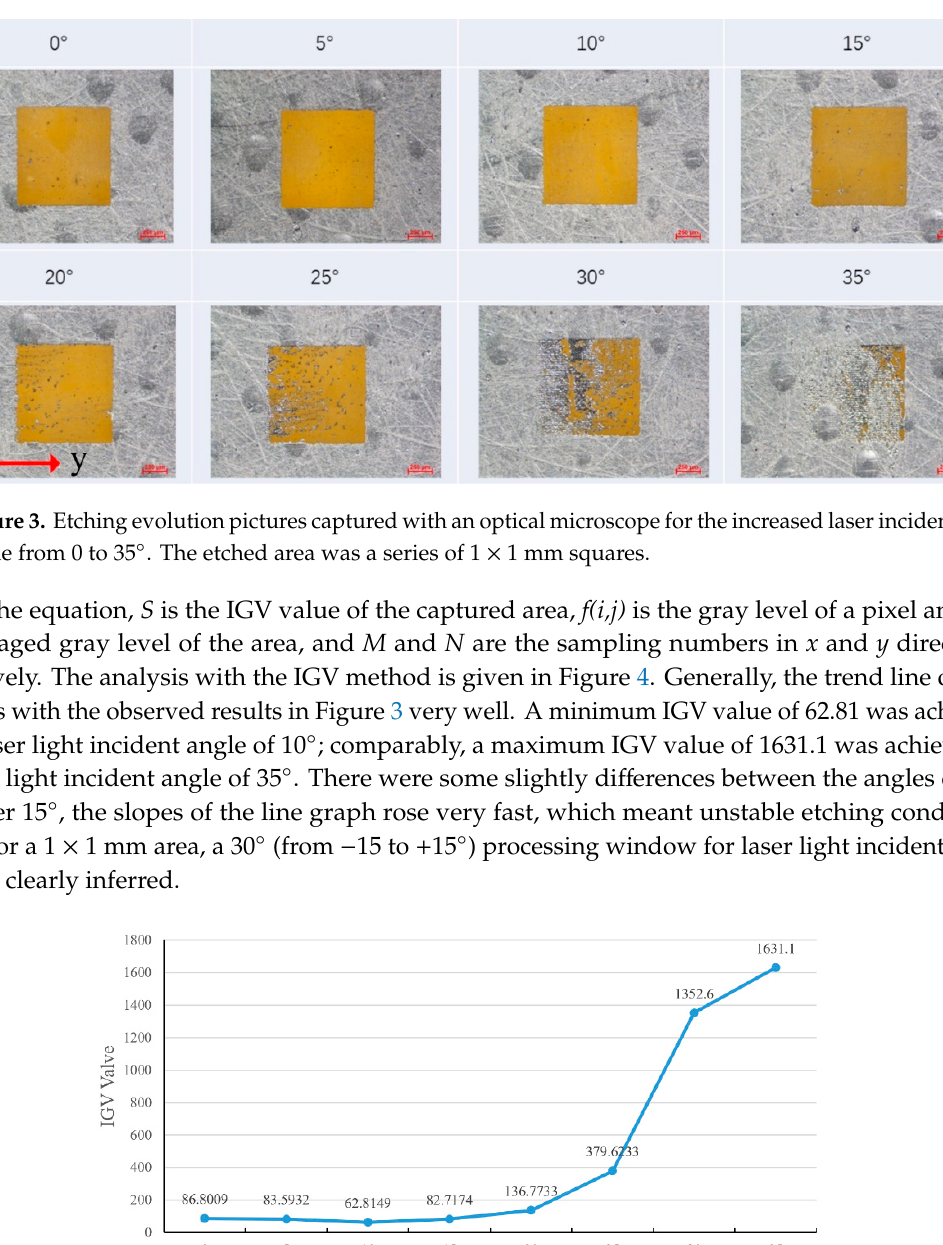
Figure 3. Etching evolution pictures captured with an optical microscope for the increased laser incident angle from 0 to 35°. The etched area was a series of 1 × 1 mm squares.